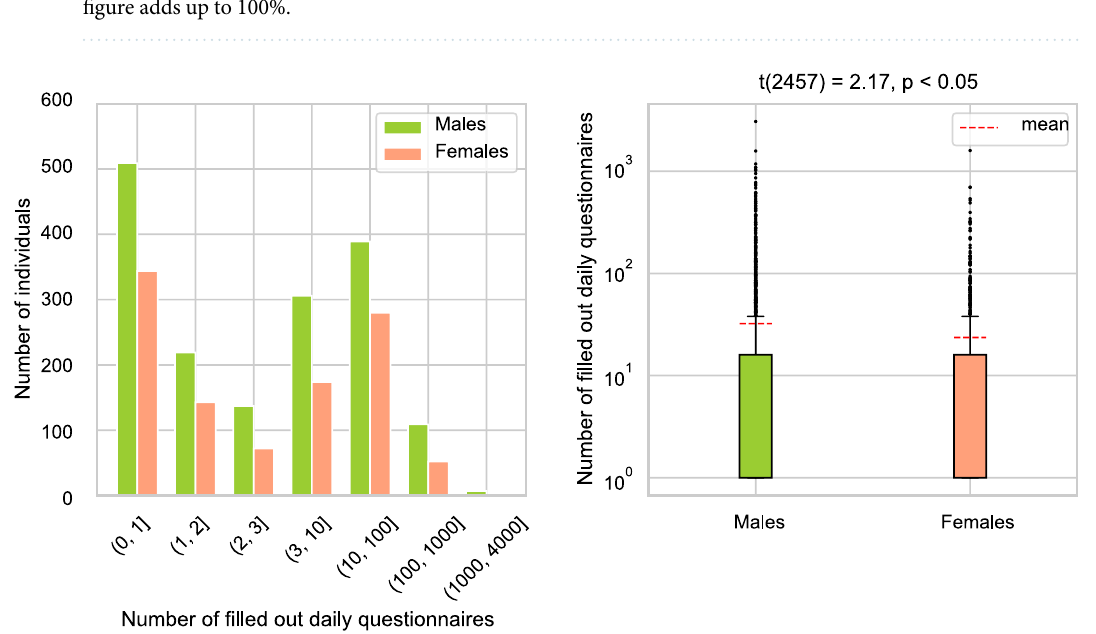
Figure 5. Number of filled out daily questionnaires per group (left) and per gender (right). The red-dashed line in the right plot indicates the mean value. Most of the individual users filled out the questionnaire only once. On average, men answered the questionnaire 32 times (± 124 std), and women 24 times (± 82 std) with t(2757) = 2.17 and p < 0.05. Notably, there is one male user that filled out the daily questionnaire 3073